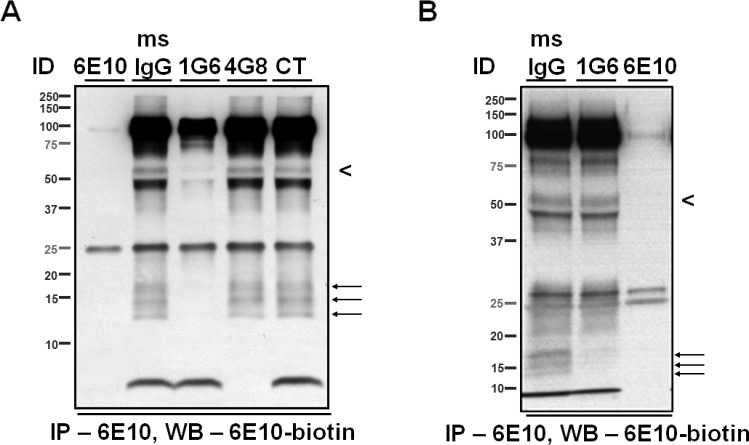
The ~55- and the ~15- kDa, 6E10-immunoreactive species contain APP metabolites located N-terminally of Aβ.(A) CSF samples were first immunodepleted using the antibodies noted above each lane, and then subjected to immunoprecipitation with 6E10, and WB was probed with biotinylated 6E10. Immunodepletion with 6E10 removed both the ~55- (arrowhead) and the ~15- kDa (arrows) proteins as expected. Immunodepletion with the 1G6 antibody fully removed the ~15-kDa species and partially removed the ~55-kDa species, indicating the presence of APP fragments located N-terminally of Aβ in these bands. In contrast, an antibody directed against the C-terminus (CT) of APP and the antibody 4G8 failed to deplete the ~55- and the ~15- kDa, 6E10-immunoreactive proteins. Note that the blot was transferred from a 10–20% Tris-Tricine gel. (B) In different CSF samples, immunodepletion with the antibody 1G6 did not reduce levels of the ~55-kDa band, but almost fully eliminated the ~15-kDa band. Immunodepletion with mouse IgG (msIgG) served as a negative control. Note that the blot was transferred from a 10.5–14% Tris-HCl gel.